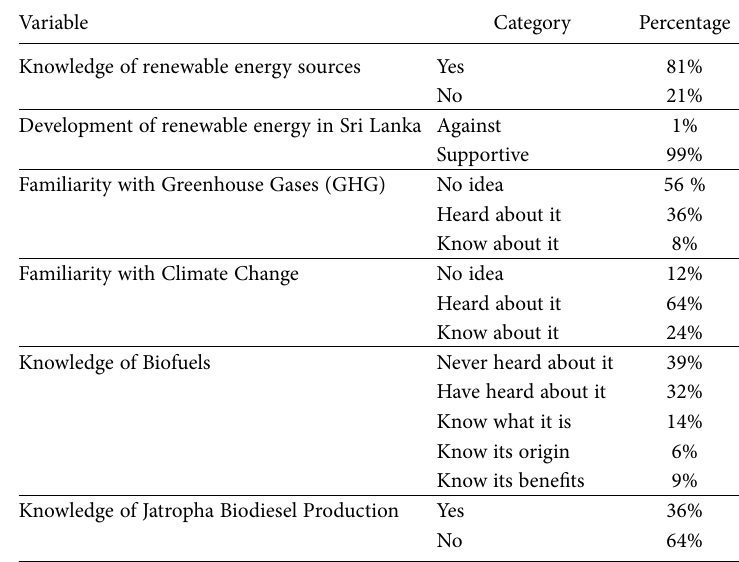
Table 3. Summary of perceptions and awareness of Bio-energy